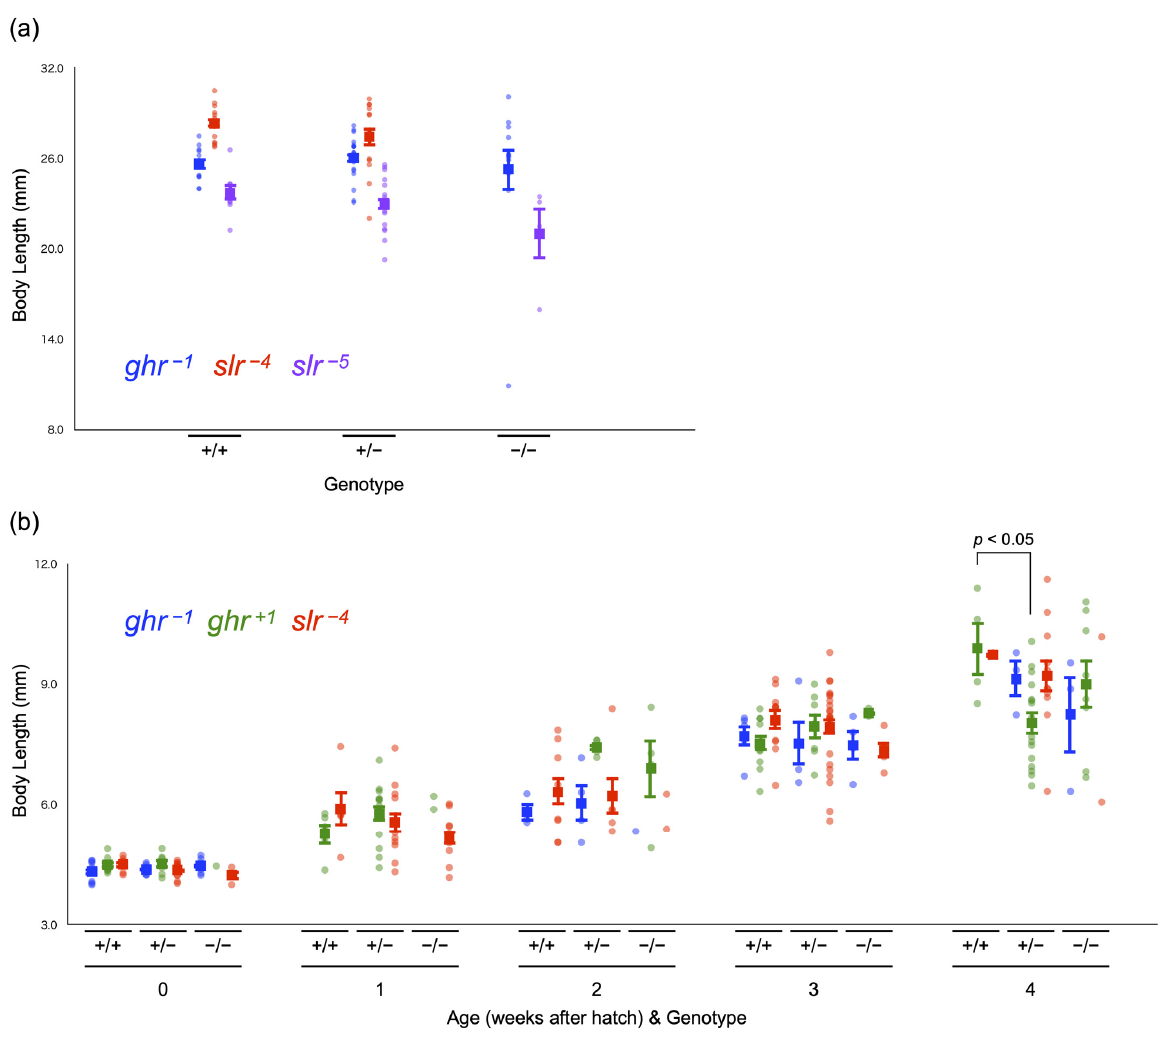
Figure 5. Body length at the adult and larval stages. ( a ) Body length of adult fish among genotypes in ghr − 1 (blue dots), slr − 4 (red dots), and slr − 5 (purple dots) individuals. ( b ) Transition of body length among genotypes during the larval stage in ghr − 1 (blue dots), ghr +1 (green dots), and slr − 4 (red dots) individuals. Genotypes are indicated as +/+ (WT fish), +/ − (heterozygotes), and − / − (homozygotes). Each dot represents the body length of each individual, and a closed box with bars indicates the mean and standard error.